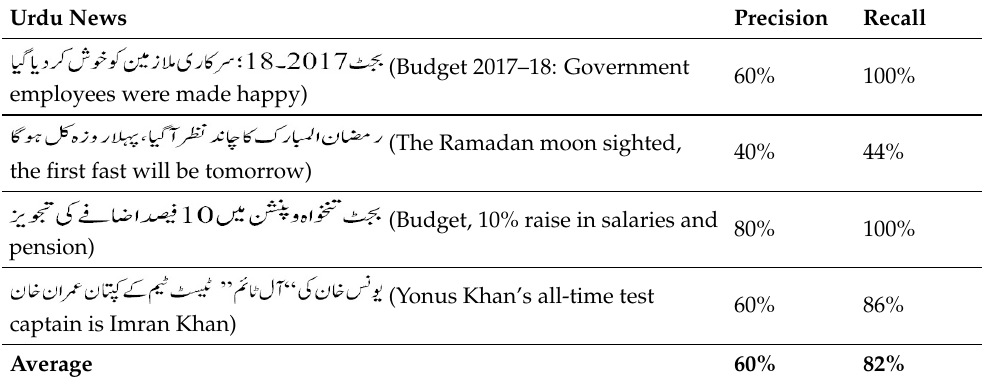
Table 8. Precision and recall for